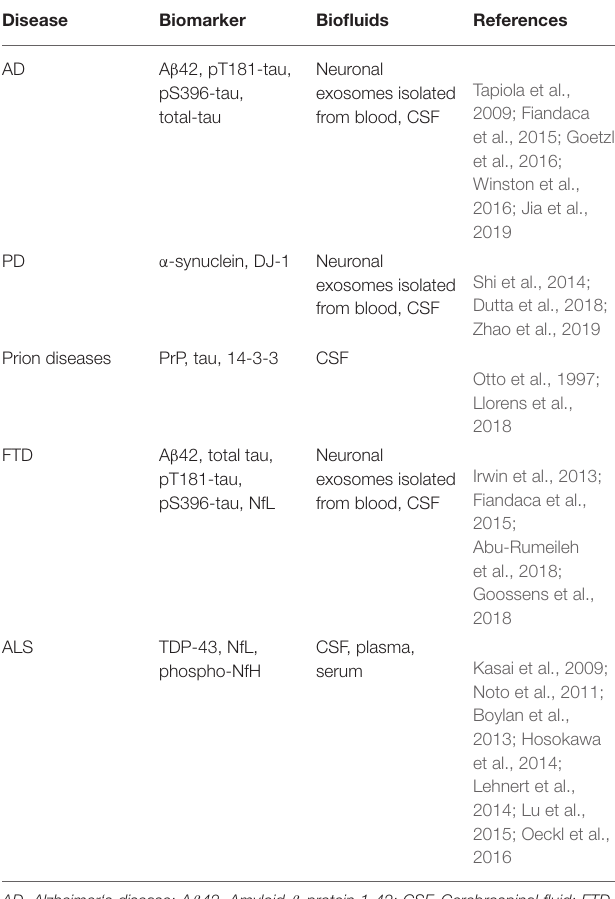
TABLE 1 | List of potential fluid biomarkers for diagnosis of neurodegenerative